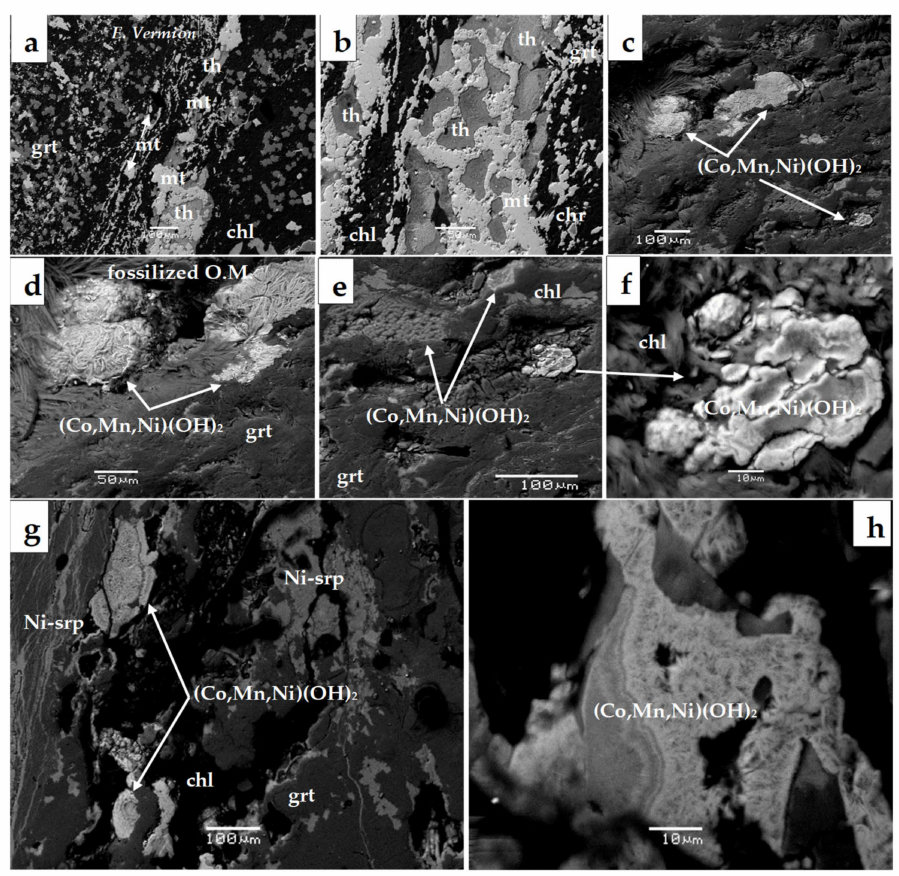
Figure 6. BSE images of metamorphosed Fe–Ni laterites from E. Vermion. Theophrastite associated with magnetite and garnet, in the form of crosscutting veinlets ( a ); the (Co–Mn–Ni)(OH) 2 associated with organic matter (O.M.) in a matrix dominated by garnet, well observed in unpolished parts of the studied sections ( b , c ); close-up view morphology of (Co–Mn–Ni)(OH) 2 ( d – h ), showing suc- cessive thin layers, composed by fine fibrous crystals ( h ). Abbreviations O.M. = organic matter;